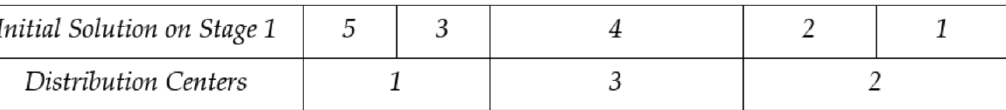
Figure 9. Initial solution of the problem.